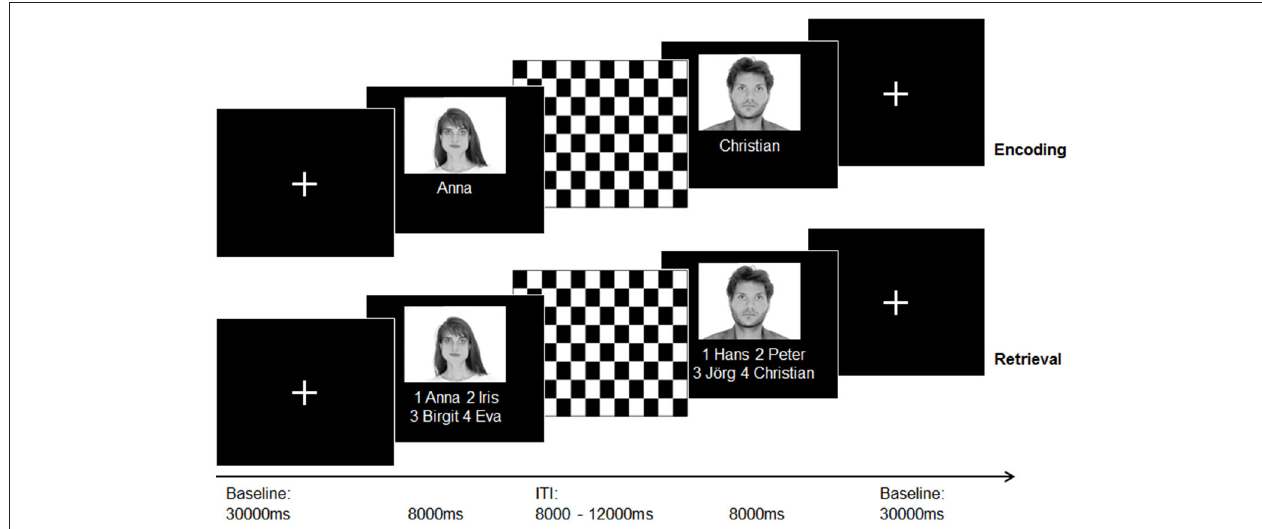
FIGURE 1 | Illustration of the experimental paradigm (face-name-association task) according to Sperling et al. (11) during the acquisition of an fMRI sequence. A total of 30 photographs of emotionally neutral, gray-scaled faces taken from the “AR” face database ( 30) were randomly assigned to 30 popular German forenames taken from an online database with popular German names